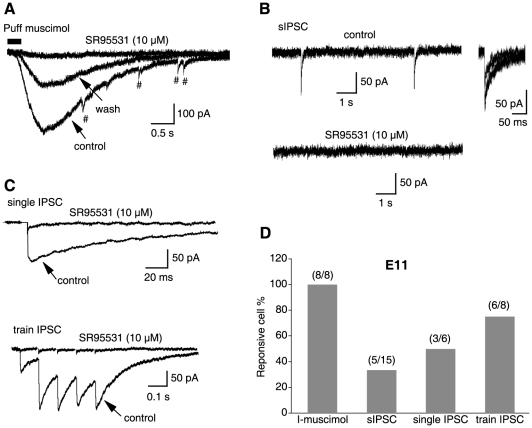
GABAergic transmission starts functioning in about half of the NL neurons at E11.
A, Puff application of a selective GABAAR agonist muscimol (10 µM) evoked an inward current that was nearly completely blocked by SR95531 (10 µM), an antagonist specific for GABAARs, indicating the presence of functional GABAARs on NL cell membrane. Spontaneous IPSCs (sIPSCs) are indicated by the symbol #. B, Voltage clamp recordings from a sample cell showing sparsely distributed sIPSCs that were eliminated by SR95531, indicating that GABAARs mediated the sIPSCs. Shown on the right are superimposed sIPSCs at an enlarged time scale. C, Electrical shocks (upper panel: single pulse stimulation; lower panel: train stimulation at 10 Hz) delivered to the GABAergic afferents to the NL evoked inward currents sensitive to SR95531, indicating the presence of functional GABA synapses. Stimulus artifacts are blanked for clarity. D, Percent of responsive cells under different recording conditions. All cells showed responses to muscimol, 5 out of 15 cells expressed sIPSCs, 3 out of 6 cells responded to the single pulse stimulation, and 6 out of 8 cells responded to the train stimulation. Cells were voltage clamped at −60 mV. DNQX (50 µM) and APV (100 µM), AMPAR and NMDAR blockers, respectively, were present in all experiments.